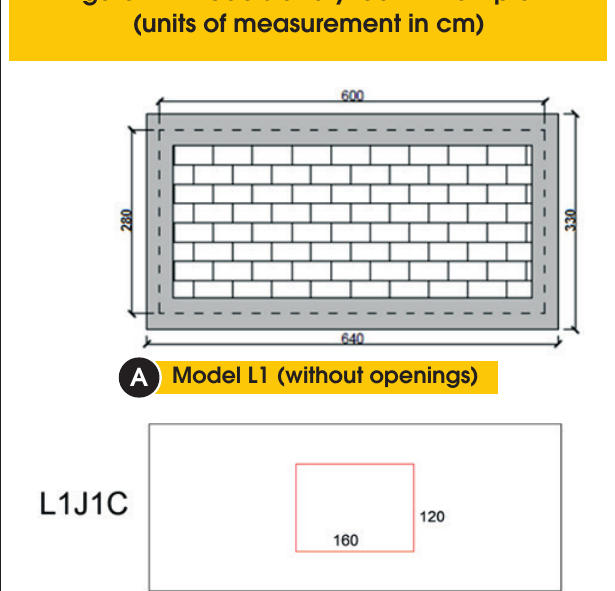
Figure 7 – Models analyzed in Example 2 (units of measurement in